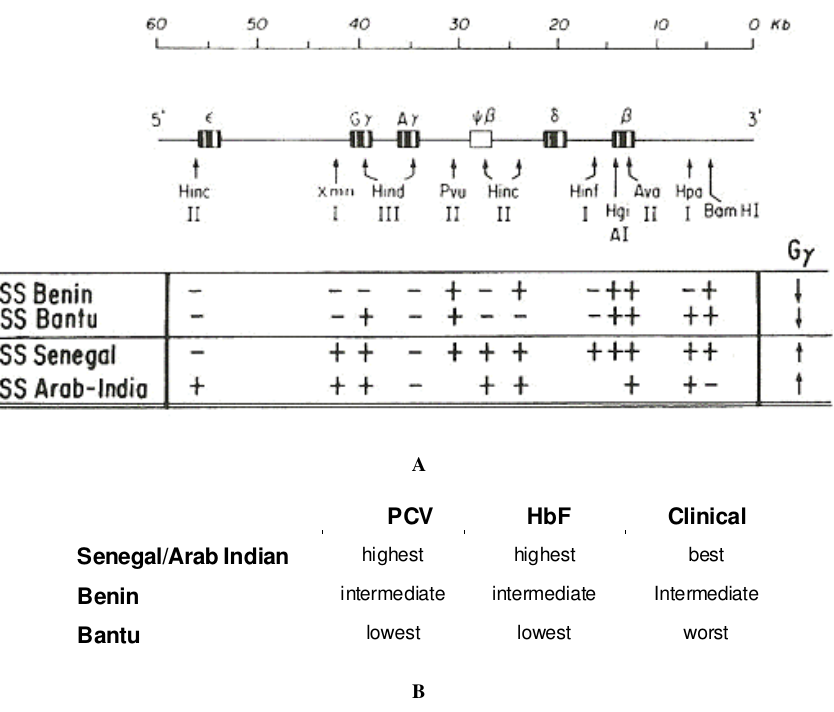
FIGURE 1. (A) Common haplotypes associated with the β S -globin gene. Arrows indicate the approximate locations of the restriction endonuclease site that recognize the SNPs that characterize each haplotype, and the restriction enzymes originally used to define each site as being positive (cut by the enzyme) or negative (not cut). The Xmn1 site is the site of cleavage by this enzyme when a T replaces the wild-type C (rs7482144). (B) General clinical and laboratory findings in common haplotypes of sickle cell anemia. These are broad generalizations, derived from the data of many patients, and an individual might not be reflective of larger